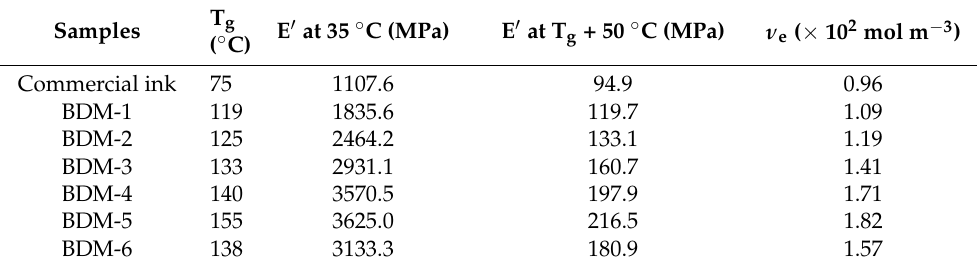
Figure 6. Curves of ( a ) storage modulus and ( b ) tan δ response to temperature for 3D-printed samples based on commercial and BDM inks. Table 4. Results of DMA test on 3D-printed samples based on commercial and BDM